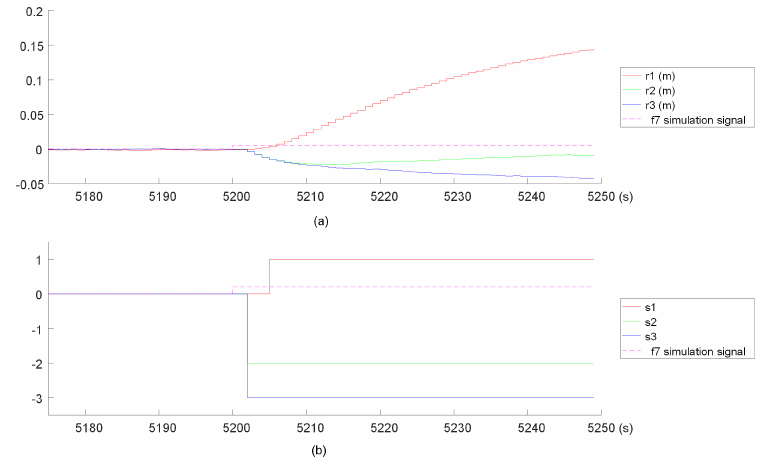
Figure 5. Examples of diagnosing in the case of the f 7 fault: ( a ) residual values and ( b ) diagnostic signal values (three-value signal (cid:104)− 1,0,1 (cid:105) scaled to an s j number). Table 12. The results of the algorithm for the input signals from Figure 5. Step Algorithm